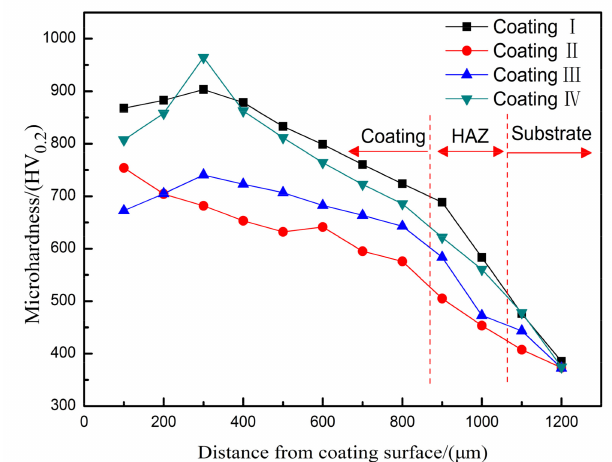
Figure 10. Microhardness profiles of the laser cladding intermetallic composite coatings under different laser